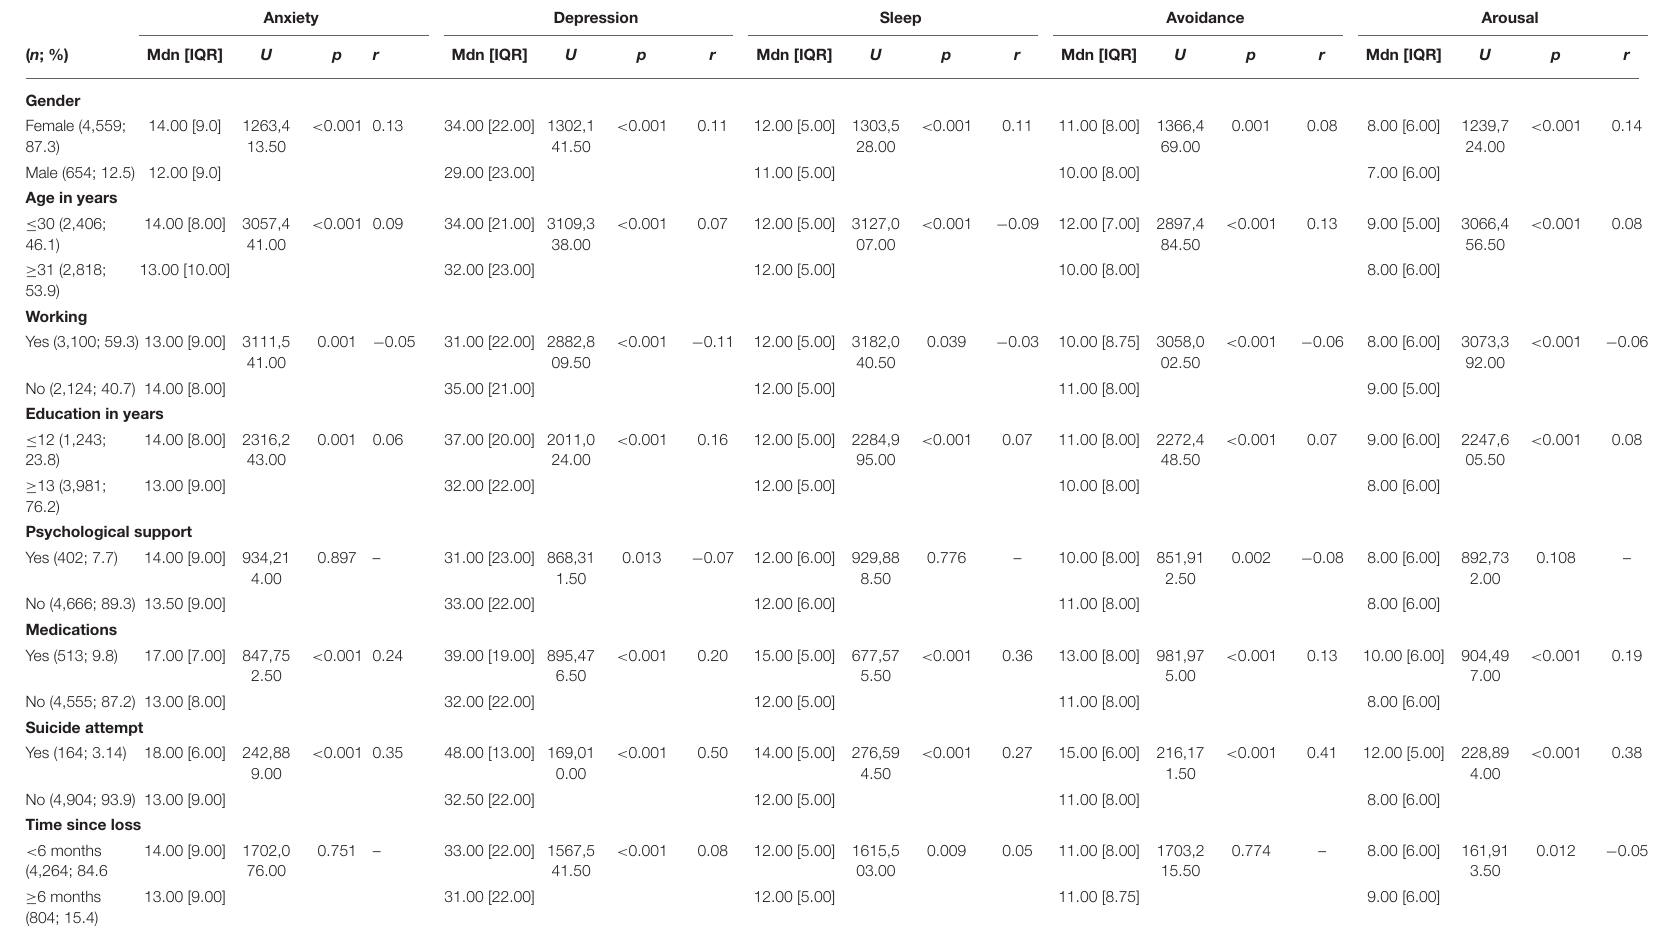
TABLE 1 | Sociodemographic characteristics of support-seeking bereaved adults during the COVID-19 pandemic. Anxiety Depression Sleep Avoidance